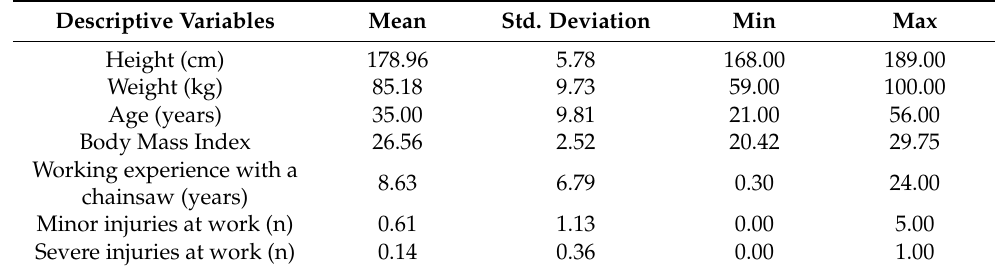
Table 5. General information from the chainsaw workers participating in the kinematic study (N = 28). Descriptive Variables